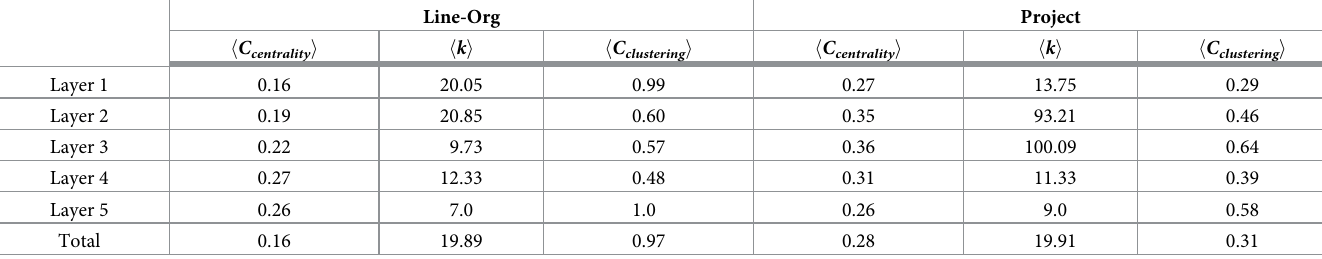
Table 1. Network statistics of empirical networks by layer.